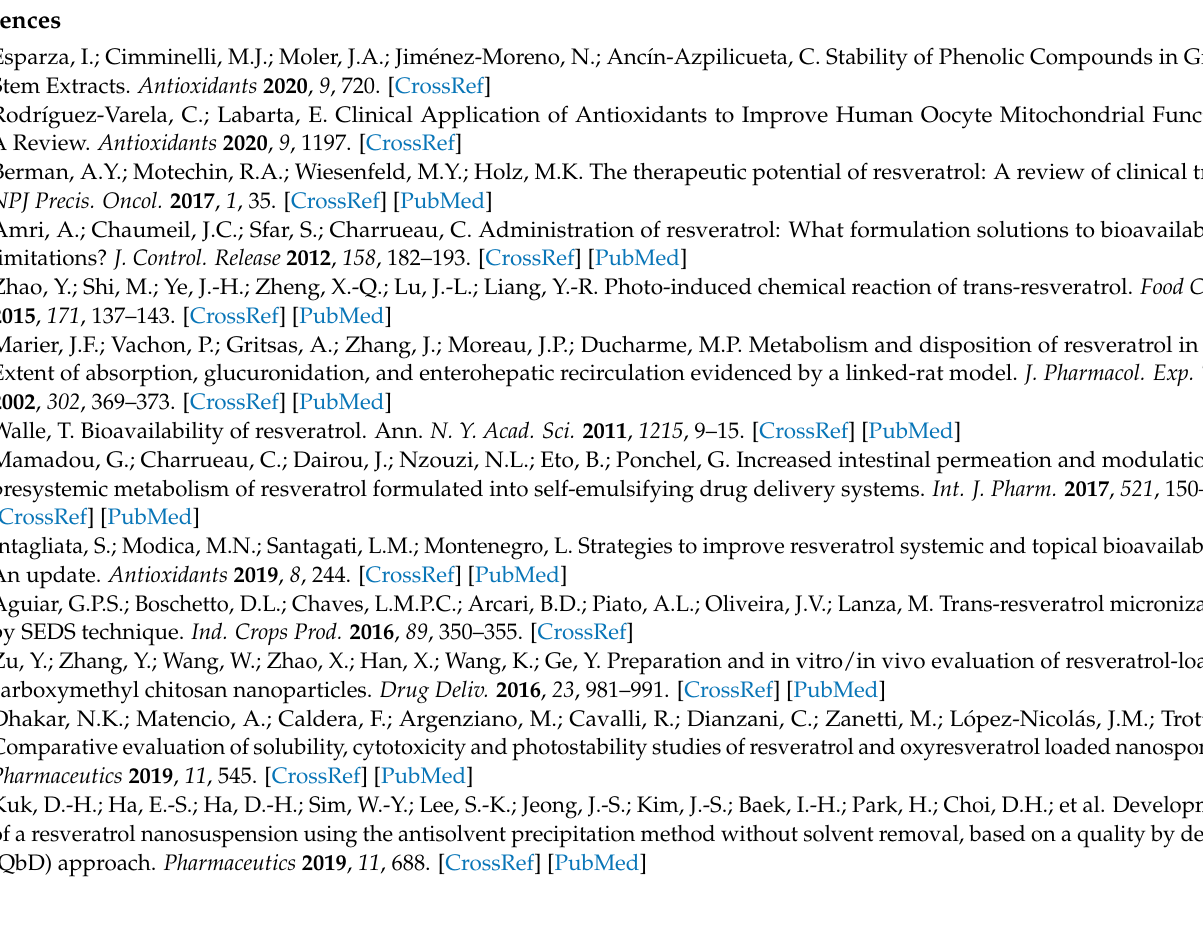
Table S2: Dissolution data (concentration, µ g/mL) of raw trans-resveratrol and solid dispersion powders produced using the spray drying process in pH 6.8 dissolution media, Table S3: Dissolution data (concentration, µ g/mL) of raw trans-resveratrol and Eudragit E/HCl solid dispersion powders produced using the spray drying process in pH 1.2 dissolution media, Table S4: Dissolution data (concentration, µ g/mL) of raw trans-resveratrol and Eudragit E/HCl solid dispersion powders produced using the spray drying process in pH 6.8 dissolution